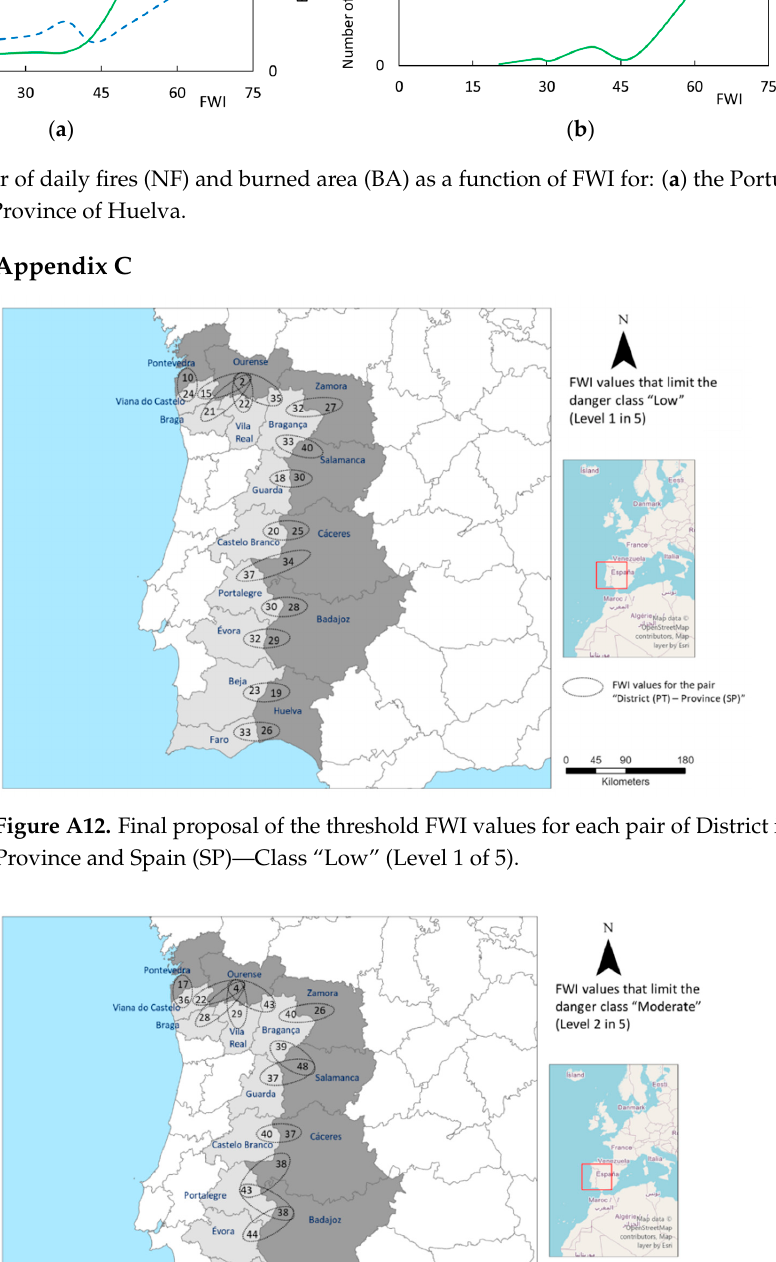
Figure A10. Average number of daily fires (NF) and burned area (BA) as a function of FWI for: ( a ) the Portuguese District of Évora and ( b ) the Spanish Province of Badajoz.